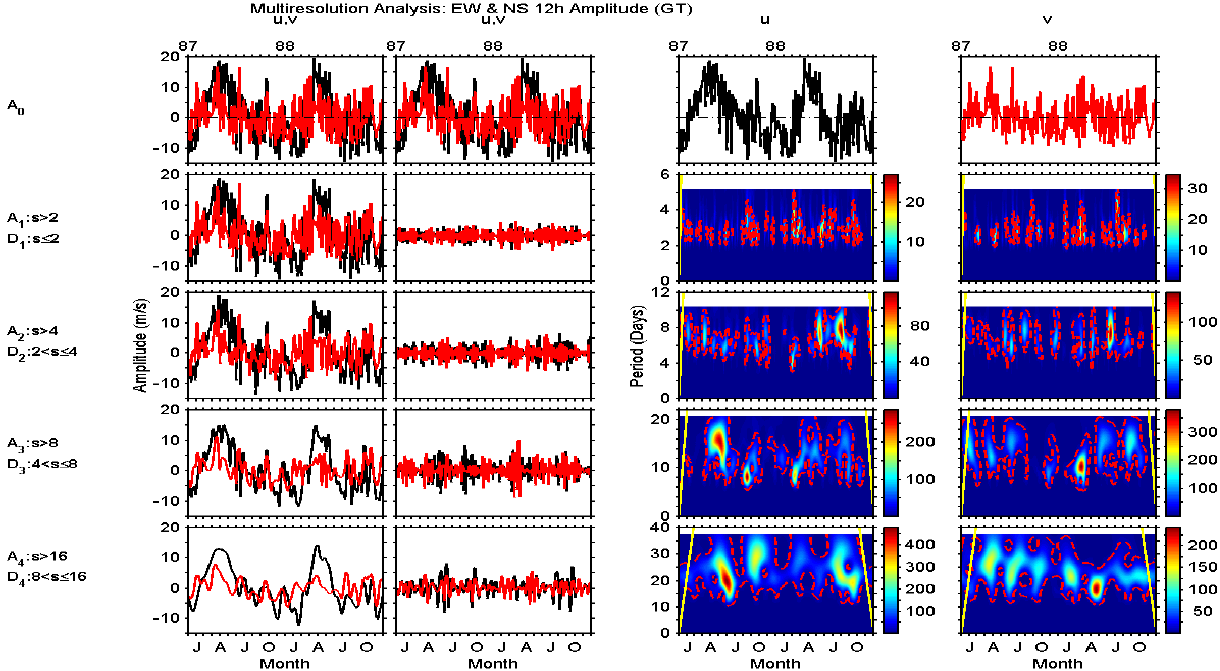
Fig. 4. Analysis of the semidiurnal tide at Grahamstown: Top row, the original signal A o . Rows 2–5, starting from the left, show (1st column) the approximations ( A m where m is the level), (2nd column) the details ( D m ), (3rd column) the spectrum of the zonal details and (4th column) the spectrum of the meridional details. The black and red time series lines represent the zonal ( u ) and meridional ( v ) amplitudes, respectively. The scale ( s ) ranges are shown on the left. The units of the colour bars are